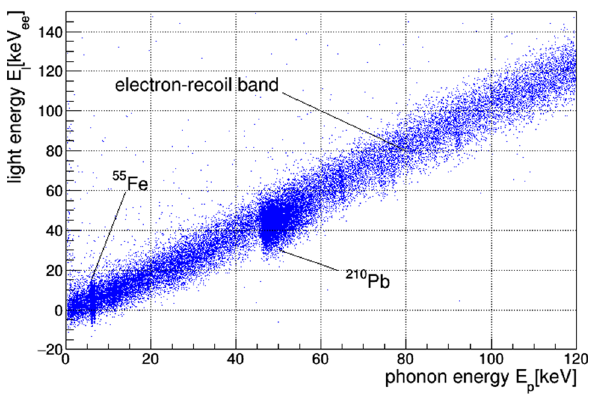
Fig. 2 The light energy E l , i.e., the scintillation light detected by the lightdetector,plottedagainstthephononenergy E p .Theelectron-recoil band, where dark-photon events and most of the background events are expected, is clearly visible. The most prominent features within this bandoriginatefromanaccidentalirradiationwitha 55 Fesource(5.9and 6.5keV) and in intrinsic contamination with 210 Pb (46 . 5keV). Above the electron-recoil band so-called excess-light events are visible (see main text for further